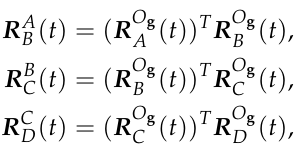
Figure 5. Structure diagram of limbs and position vector of each joint. ( a ) Limb L 2 ; ( b ) Limb L 3 . The attitude transformation between two adjacent sensors is defined by Equation